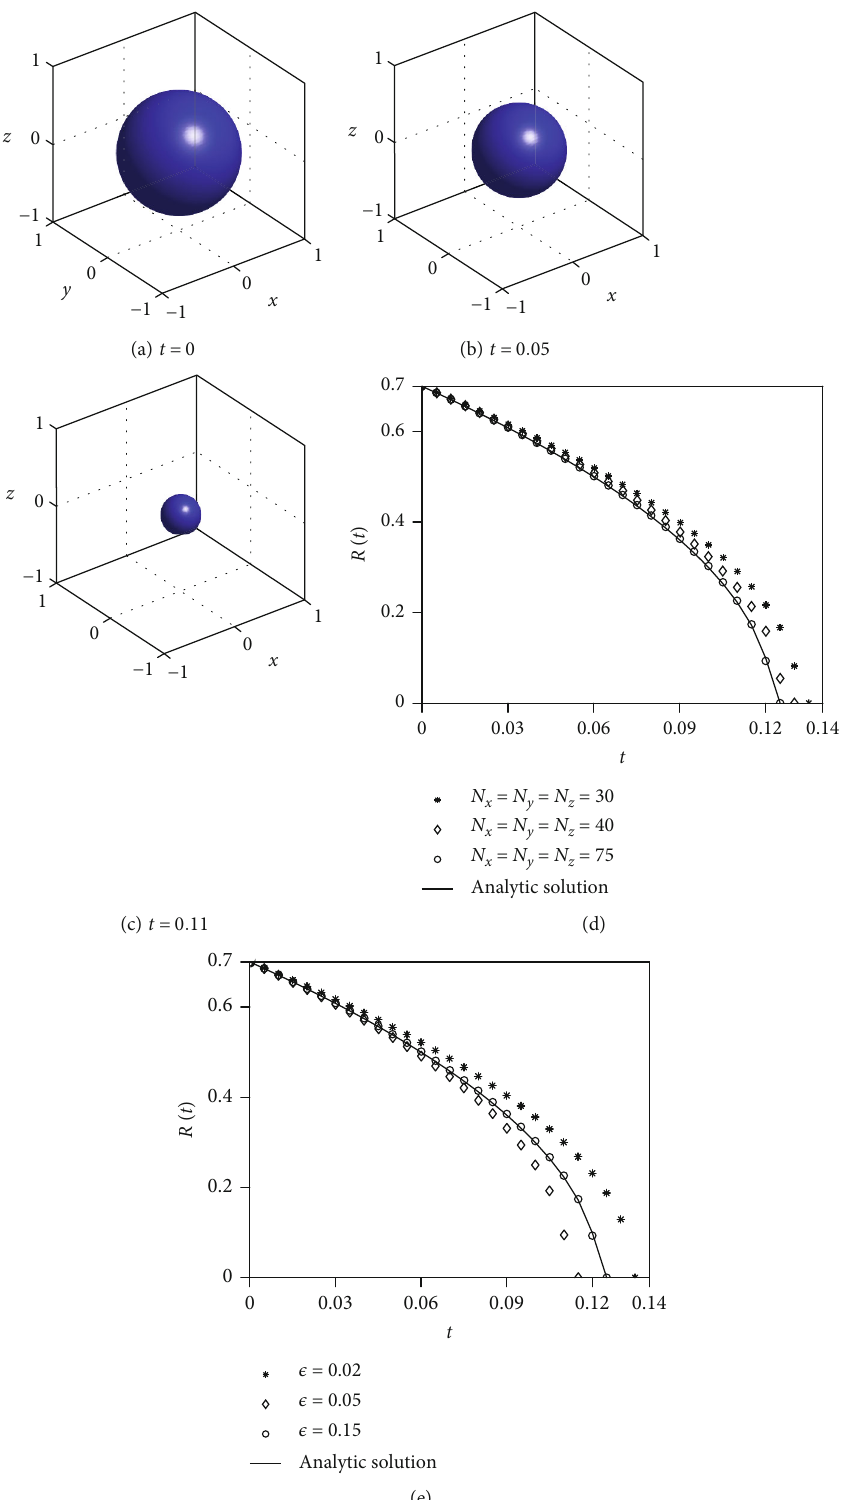
Figure 2: Given a sphere (9), (a) – (c) are the temporal evolution of the sphere and (d, e) are the changes in its radius according to di ff erent grid sizes and ϵ values,